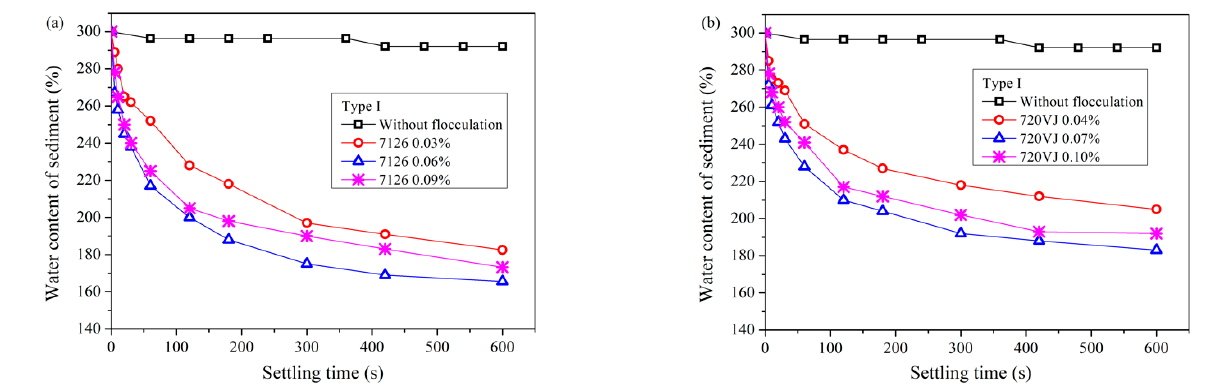
Figure 5. Sedimentation results of slurry (Type Ⅰ ) after pretreatment with APAM. ( a ) 7126. ( b ) 720VJ.